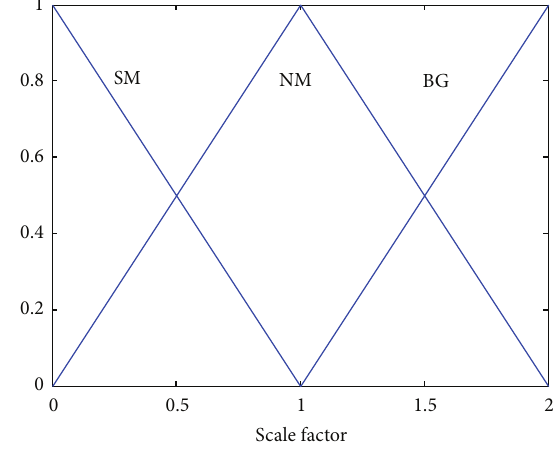
Figure 4: Defuzzification for scale